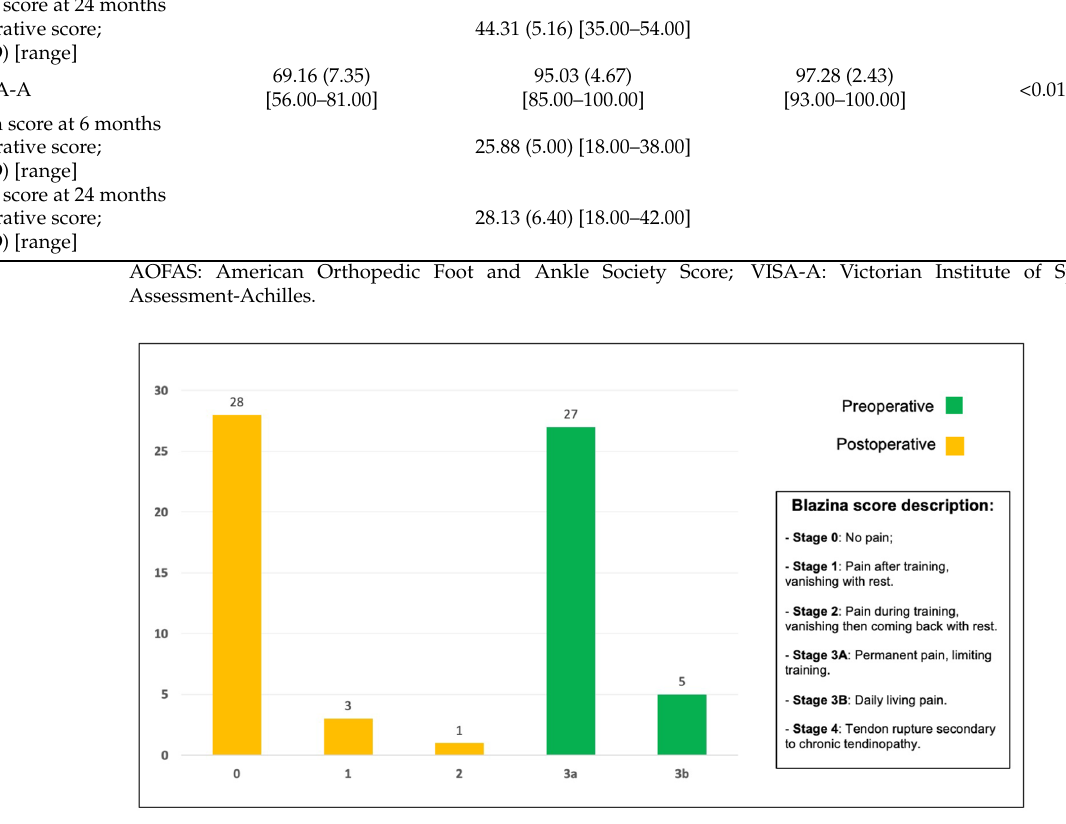
Figure 5. Blazina scores of the 32 patients before surgery and at 6 months.